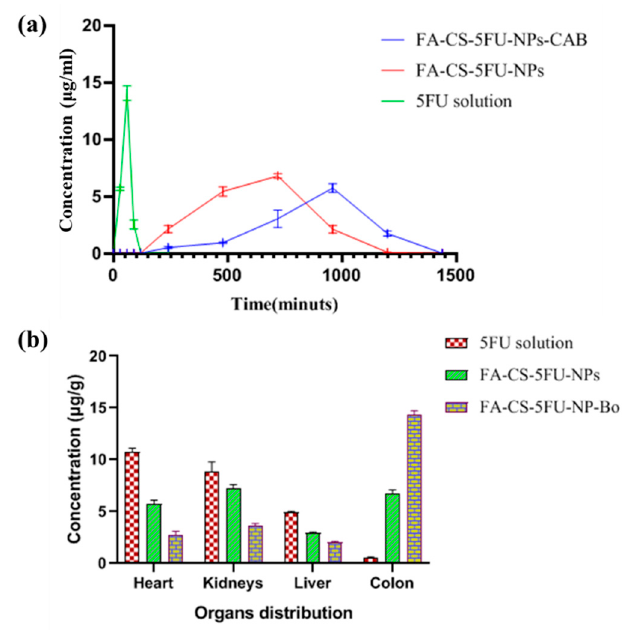
Figure 9. ( a ) Pharmacokinetic study and ( b ) biodistribution